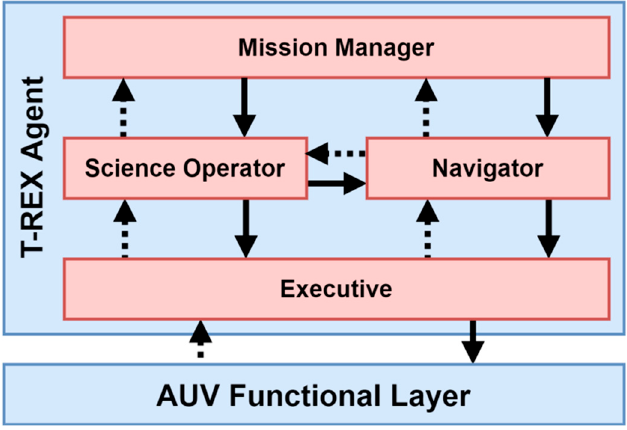
Figure 9. An example T-REX agent composed of four reactors.